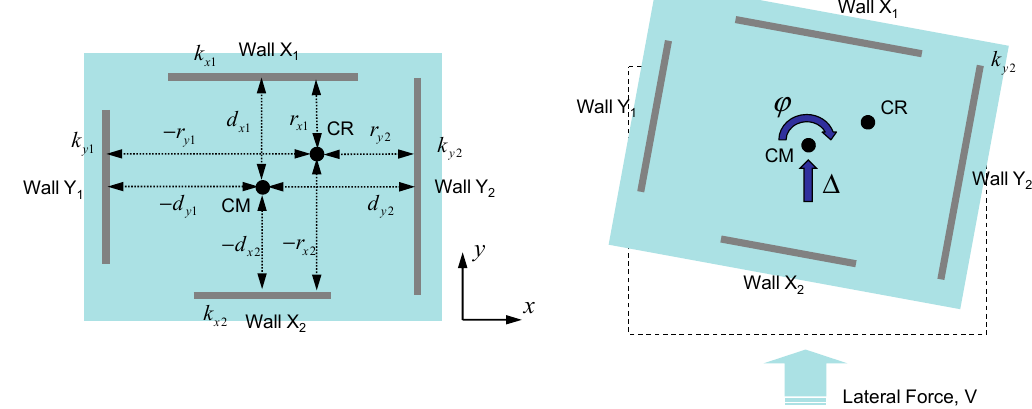
Figure 1. Representative asymmetric wall structures under the application of a lateral force and its deformed shape.